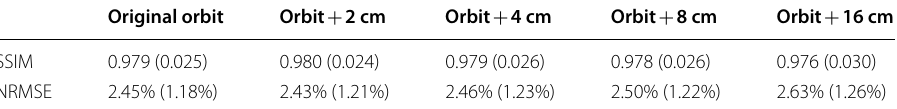
Table 4 Analysis of detector orbit